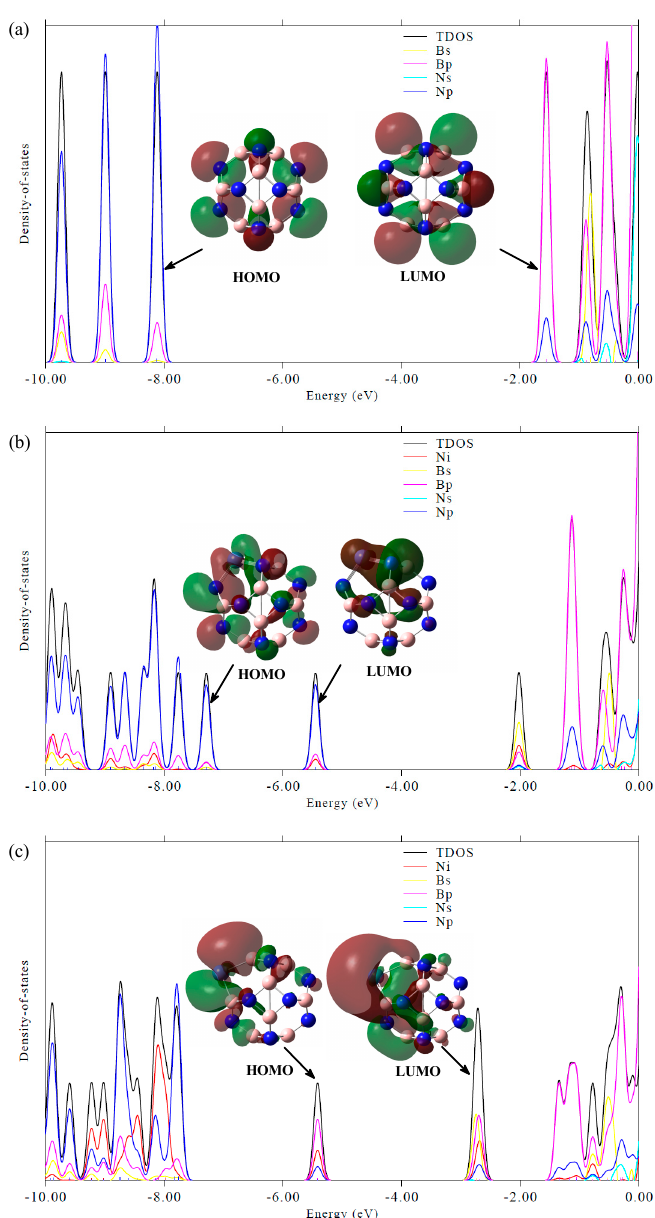
Figure 3. The TDOS and PDOS of B 12 N 12 ( a ), B 11 N 12 Ni ( b ) and B 12 N 11 Ni ( c ) and their calculated HOMO and LUMO.